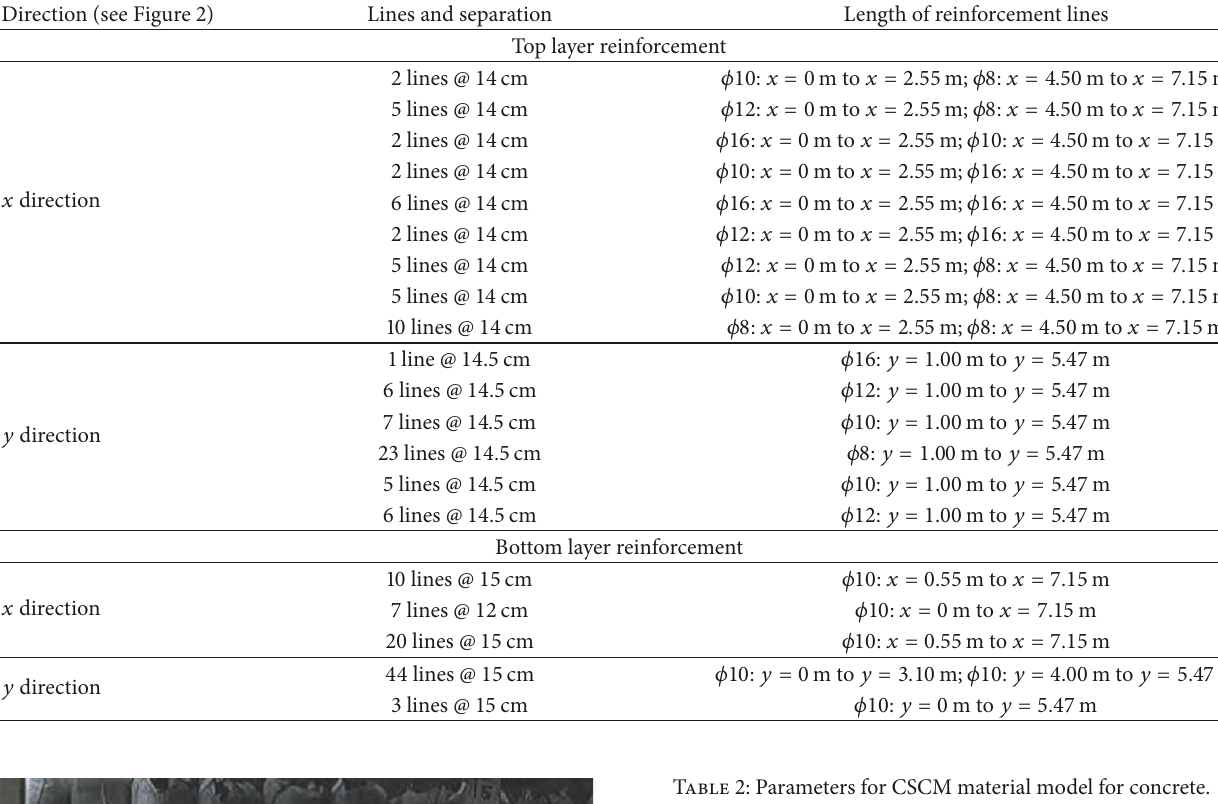
Table 1: Distribution of reinforcement in a quarter of a slab (Figure 2) of the test structure.